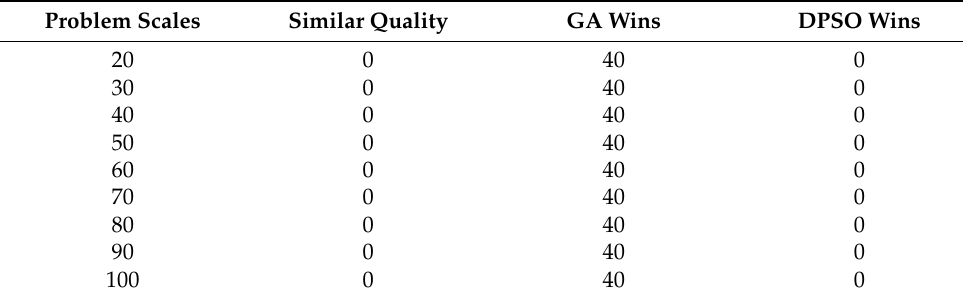
Table 5. Average fitness values of the GA and DPSO algorithm. Problem